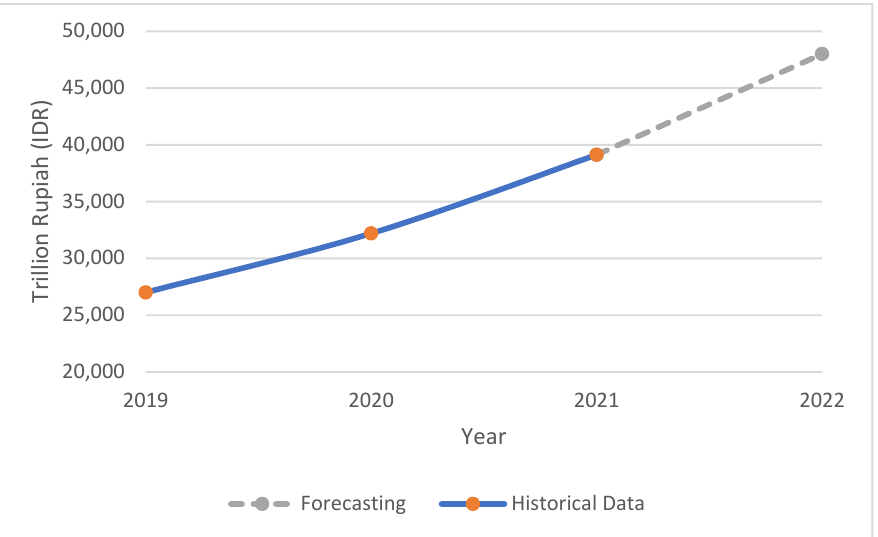
Figure 3. Digital banking transaction volume data in Indonesia (source: Bank